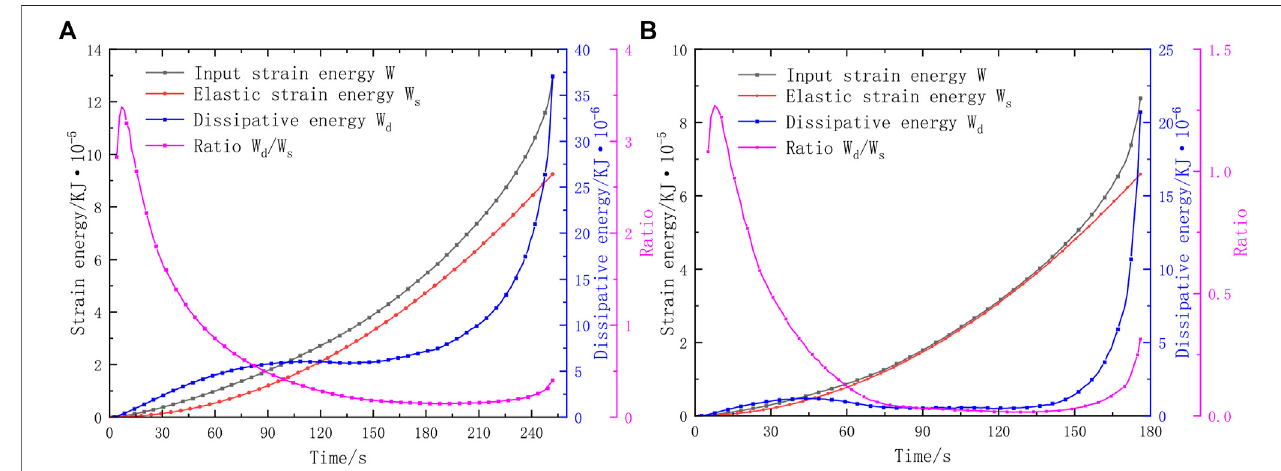
FIGURE 7 | Energy evolution in layered sandstone with an anchor: (A) Anchor 45 ° ; (B) Anchor 90 ° .